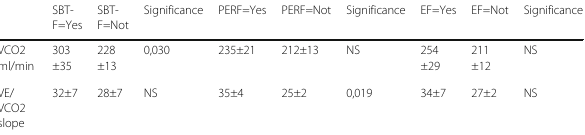
Table 2 (abstract 0150). Association among volumetric capnography variables and SBT-F, PERF or EF